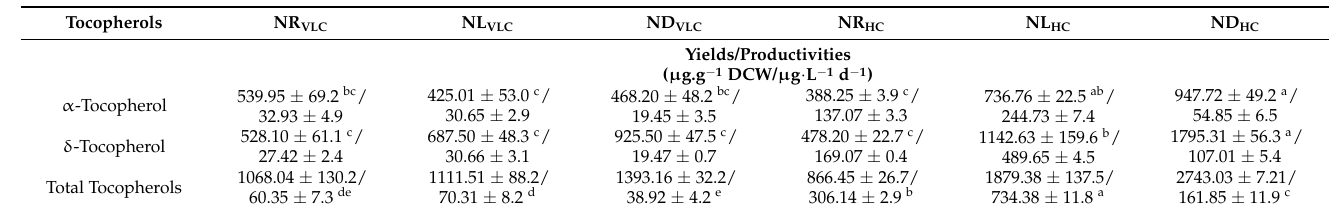
Table 3. Summary of tocopherol yields and productivities on the 10th day of cultiva-tion subjected to NR VLC , NL VLC , ND VLC , NR HC , NL HC , and ND HC conditions in the native isolate Monoraphidium sp. CABeR41. Values indicated are mean average ( n = 3) ± S.E.; different lowercase letters indicate the statistical significance by two-way ANOVA with p -value < 0.05 using post hoc analysis by Tukey’s honestly significant difference (HSD).